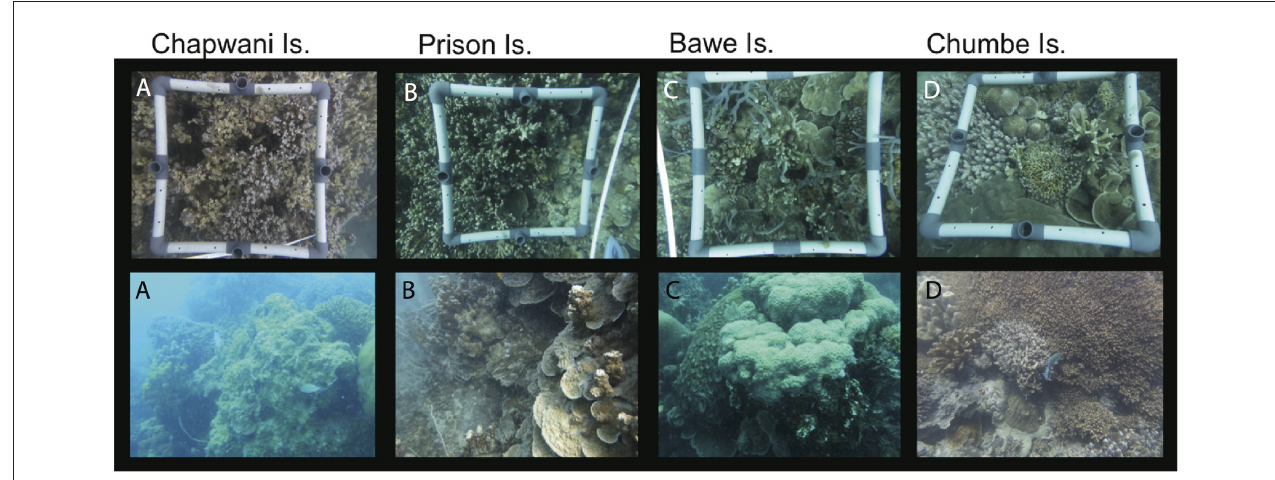
TABLE 2 | Comparative table showing the reef structural complexity or rugosity measured at the study sites. Location Complexity Mean ± SD Depth (m) Prison 1.47 ± 0.33 5 Prison 1.51 ± 0.24 10 Bawe 1.35 ±